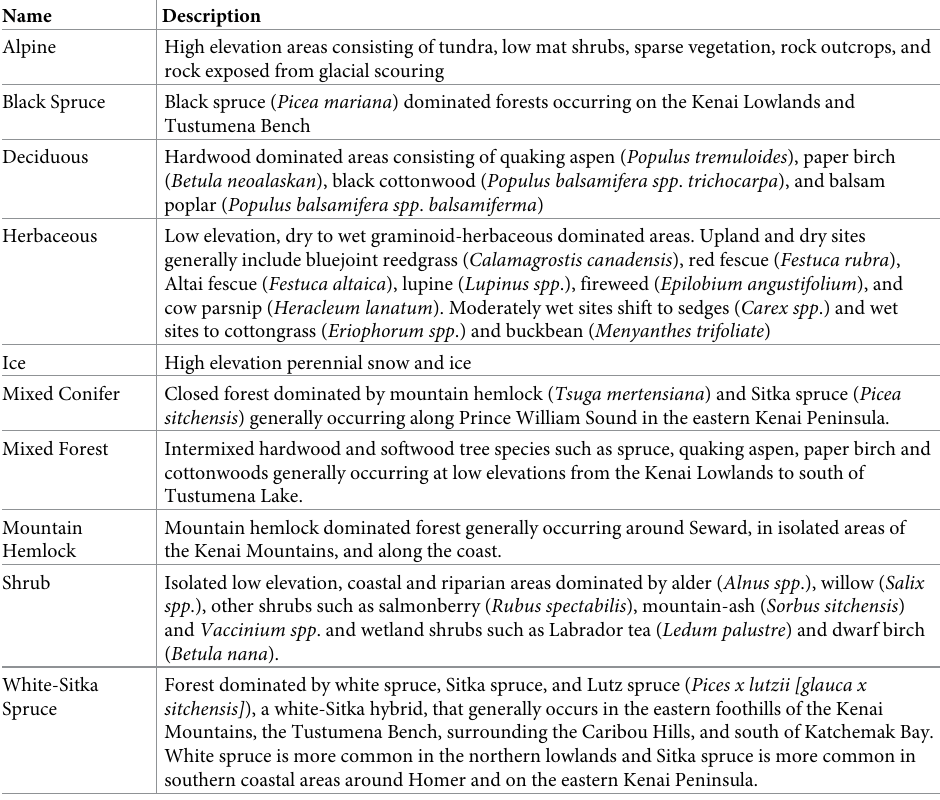
Table 1. Vegetation communities. Descriptions of the ten vegetation communities found on the Kenai Peninsula, Alaska. Ecological type was derived from a 2002 Landsat classification and used to develop a climate envelope model to forecast future ecological